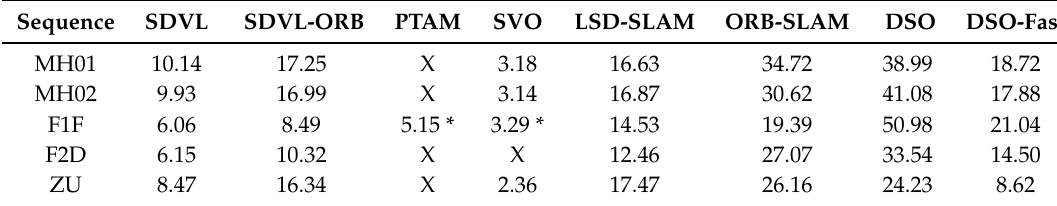
Table 4. Efficiency comparative (in